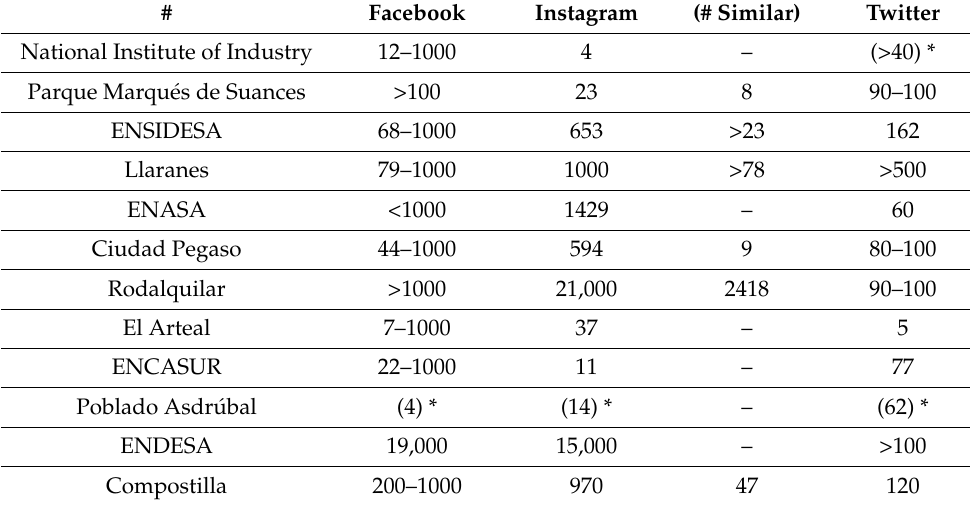
Table 6. Results of sampling #2.